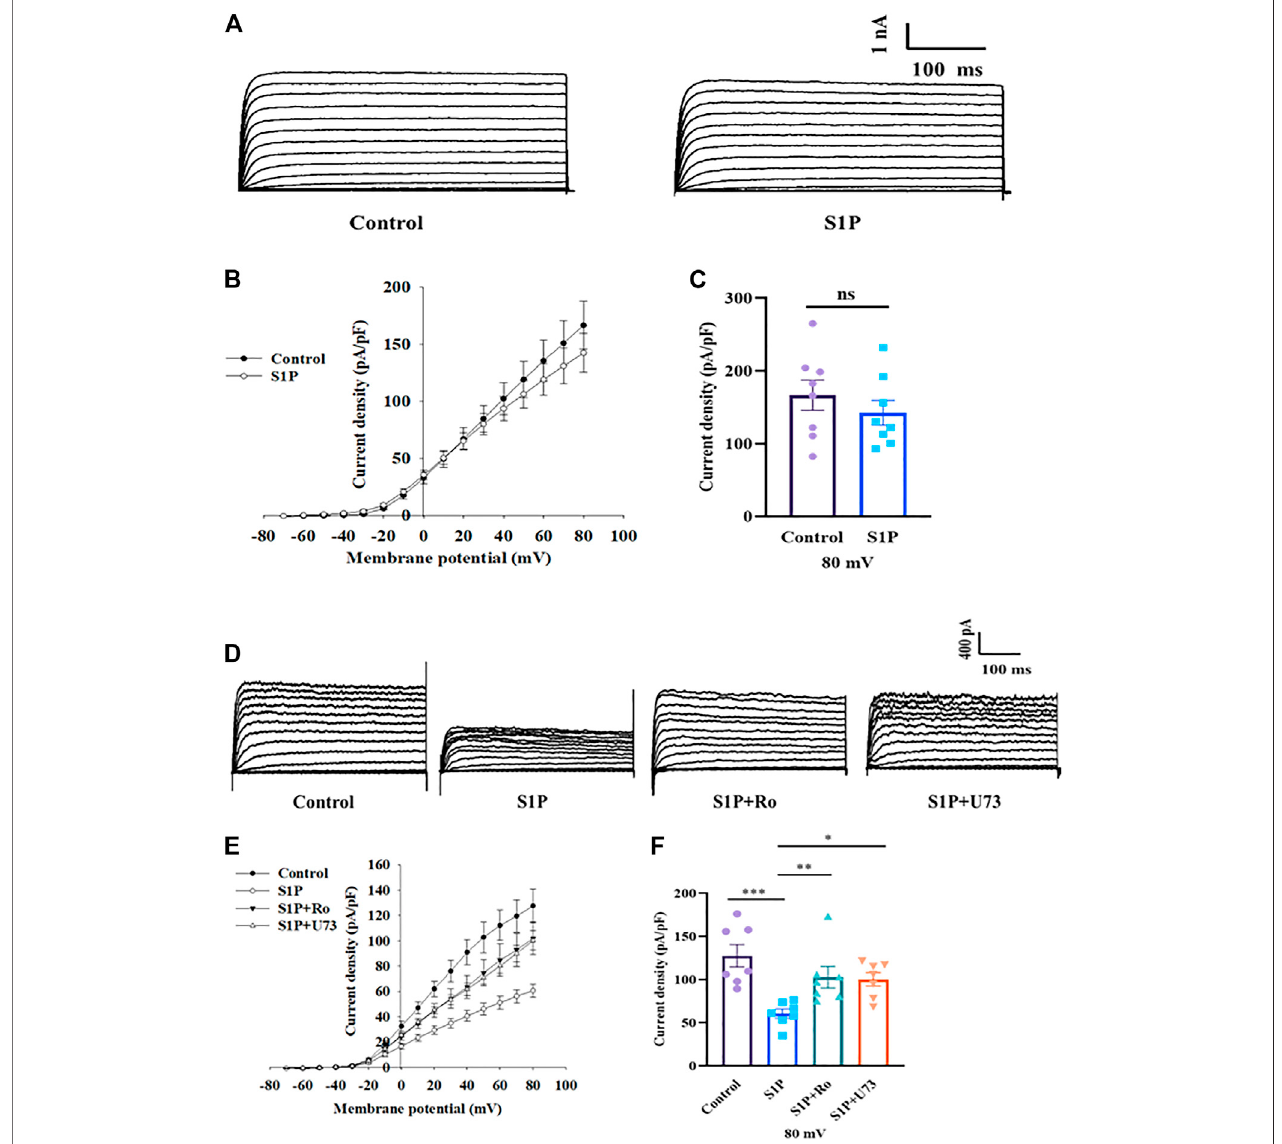
FIGURE 6 | Sphingosine 1-phosphate (S1P) had no direct effects on Kv2.1 channels but regulated them by modulating phospholipase C and protein kinase C (PLC/PKC)signaling pathway. (A) Representativecurrenttraces inChinesehamsterovary(CHO)-Kv2.1 cellsrecorded intheabsenceand presence ofS1P(10 μ M). (B) Current-voltage relationship curves of Kv2.1 channels from CHO-Kv2.1 cells. (C) Summary of the mean current densities of Kv2.1 channels recorded at 80 mV depolarization ( n (cid:2) 8; ns, not signi fi cant; by unpaired two-tailed Student ’ s t test). (D) Representative current traces recorded after β cells were treated with S1P (10 μ M)inthepresenceofU73122(U73,10 μ M)orRo31-8220(Ro,10 μ M). (E) Current-voltagerelationshipcurvesofKvchannelsunderdifferenttreatmentconditions. (F) Summary ofthe mean current densities ofKvchannels recorded at 80 mV depolarization ( n (cid:2) 7). * p < 0.05, ** p < 0.01, *** p < 0.001;by one-way ANOVA. The results represent by the mean ±